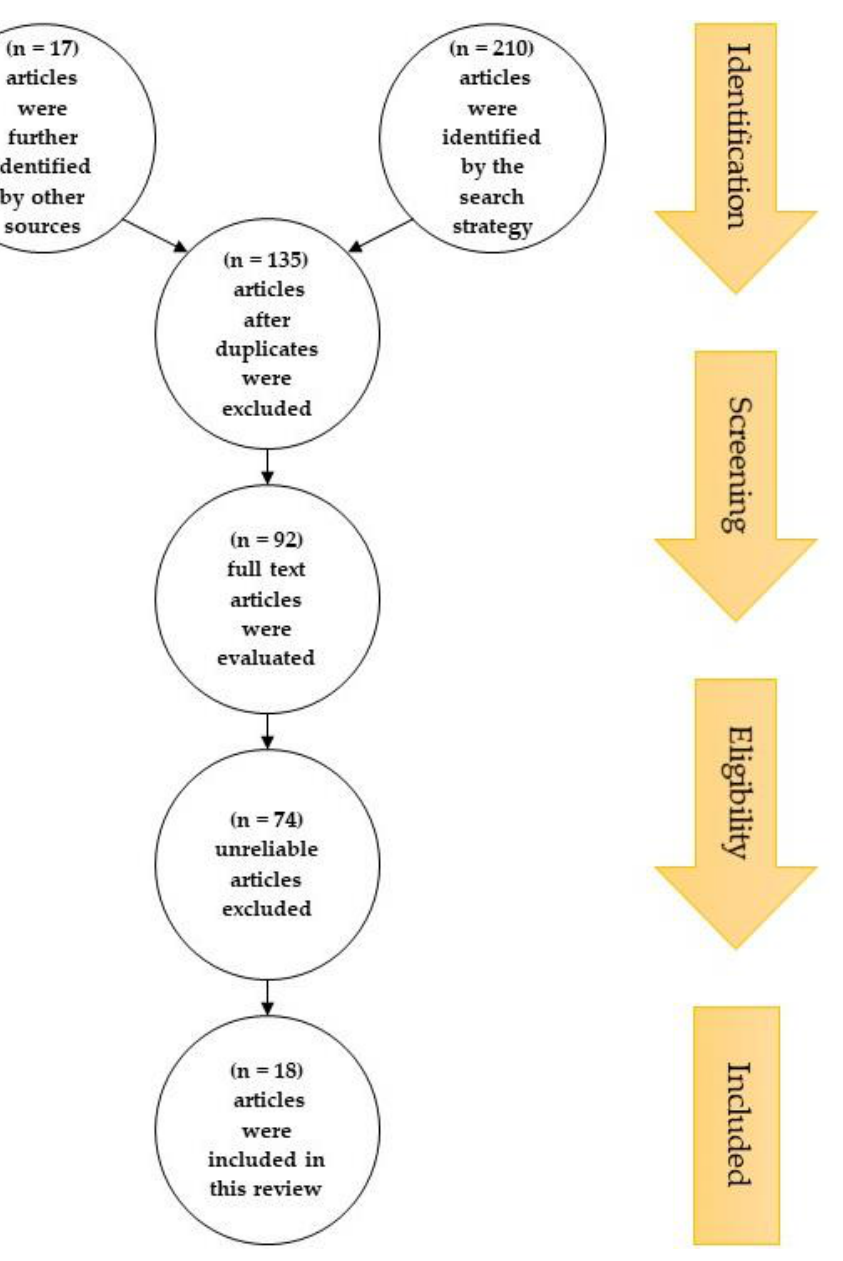
Figure 1. PRISMA flow diagram showing the study selection and identification. There were 210 articles; additionally, 17 articles were further identified by searching through the reference lists of relevant review. After duplicates were excluded, 135 articles were selected by title and abstract for their eli- gibility. From these, 92 articles were evaluated by their full texts, with 74 articles excluded due to unreliable data. Consequently, 18 articles were included in this review.